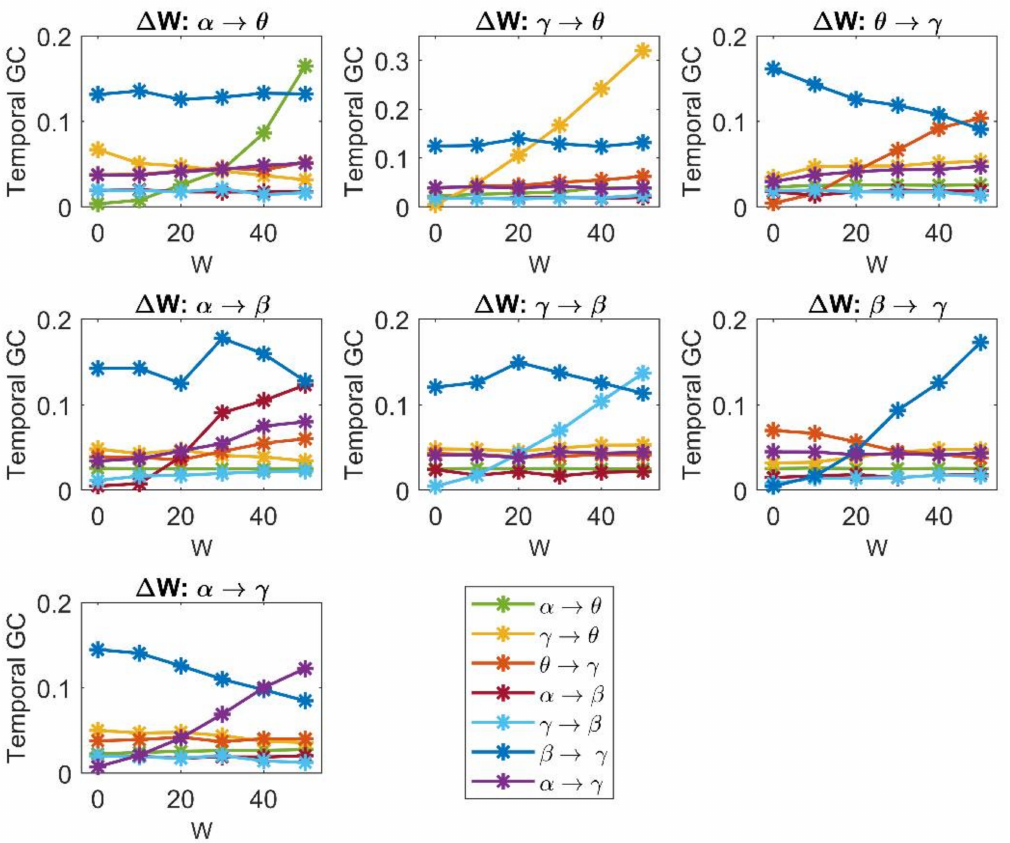
Figure 6. Values of connectivity among the ROIs estimated with the temporal Granger estimator, with reference to the network in Figure 2A, when one connection is progressively varied in the x -axis (from 0 to 50, with step of 10), and the other connections are maintained at the basal value as in Figure 2A. It is worth noting that the estimator is able to detect the progressive increase in a single synaptic strength, while the other estimates remain almost constant. As an exception, we observed that the increase in a synapse entering into ROI γ is often associated with a decrease in another synapse entering the same ROI. It is also worth noting the higher sensitivity of the estimator to the connection γ → θ